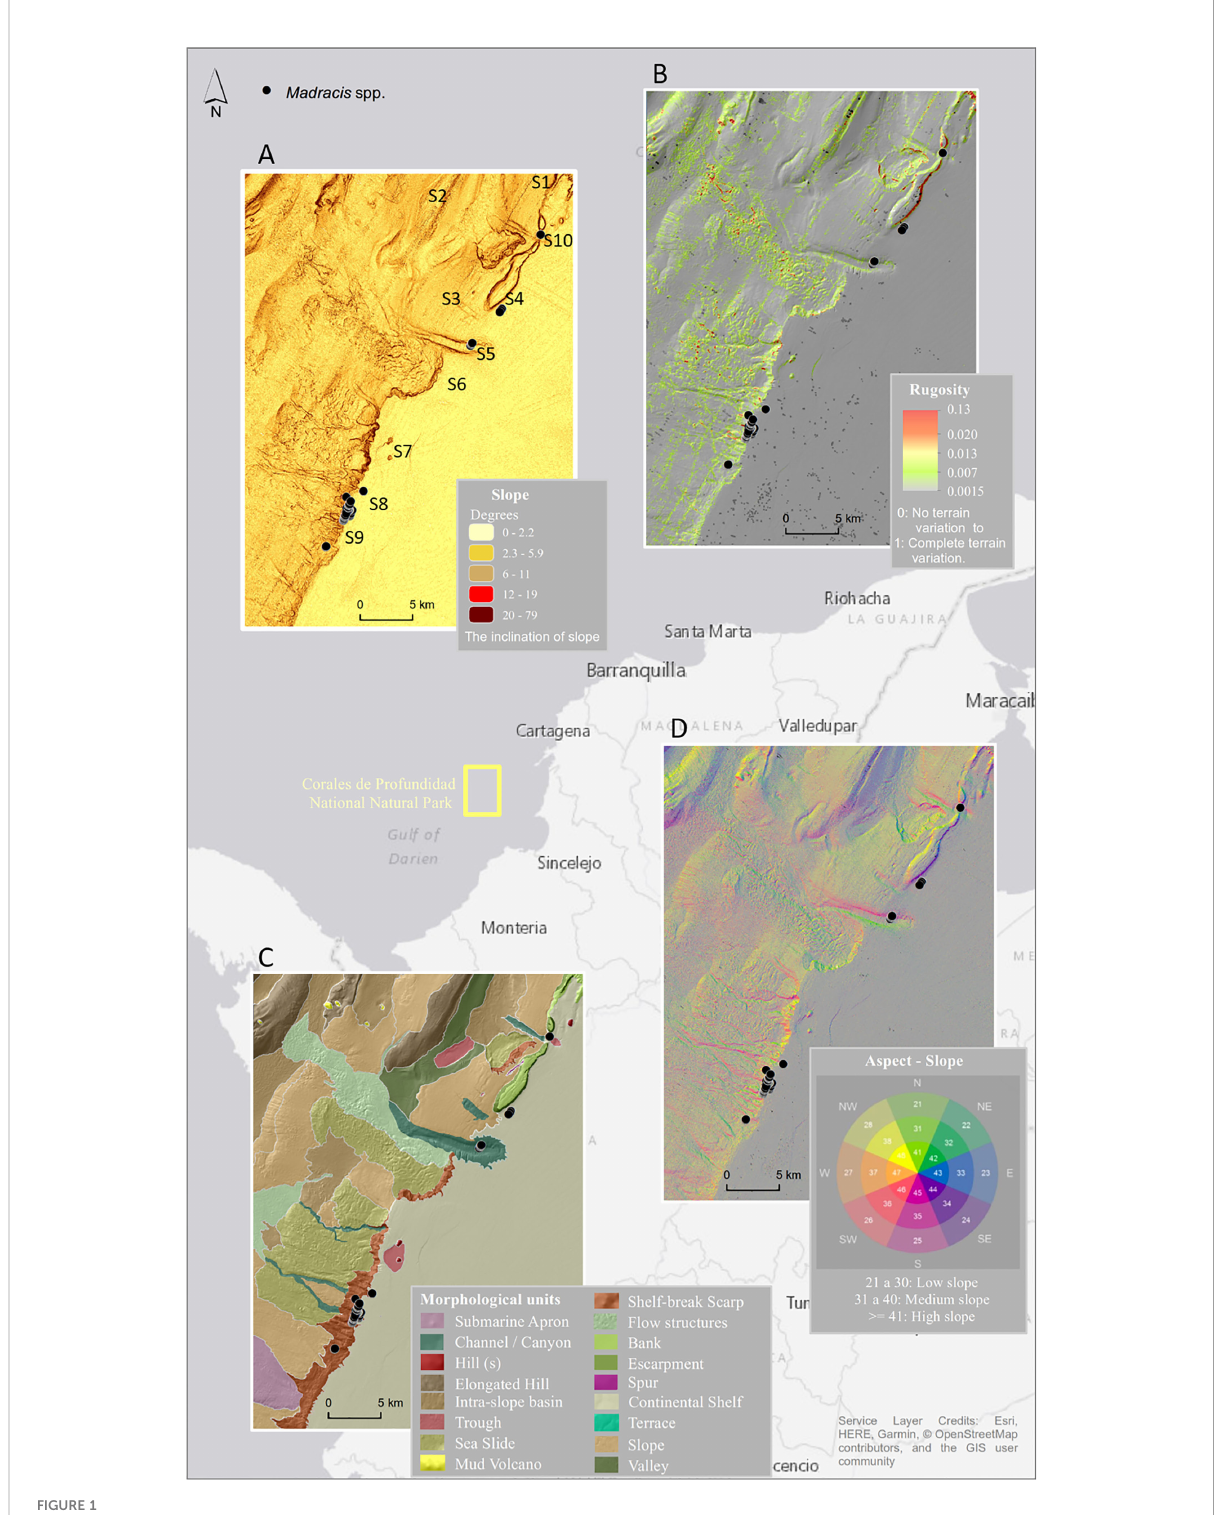
FIGURE 1 Study areas and sectors (S) where video transects were carried out; black dots are the location of Madracis spp. coral patch occurrences obtained from the analysis of the ROV video transects. (A) Slope map. (B) Rugosity. (C) Morphological units. (D) Aspect map. The background image shows the area of the Corales de Profundidad National Natural Park in the Colombian Caribbean. ROV, remotely operated